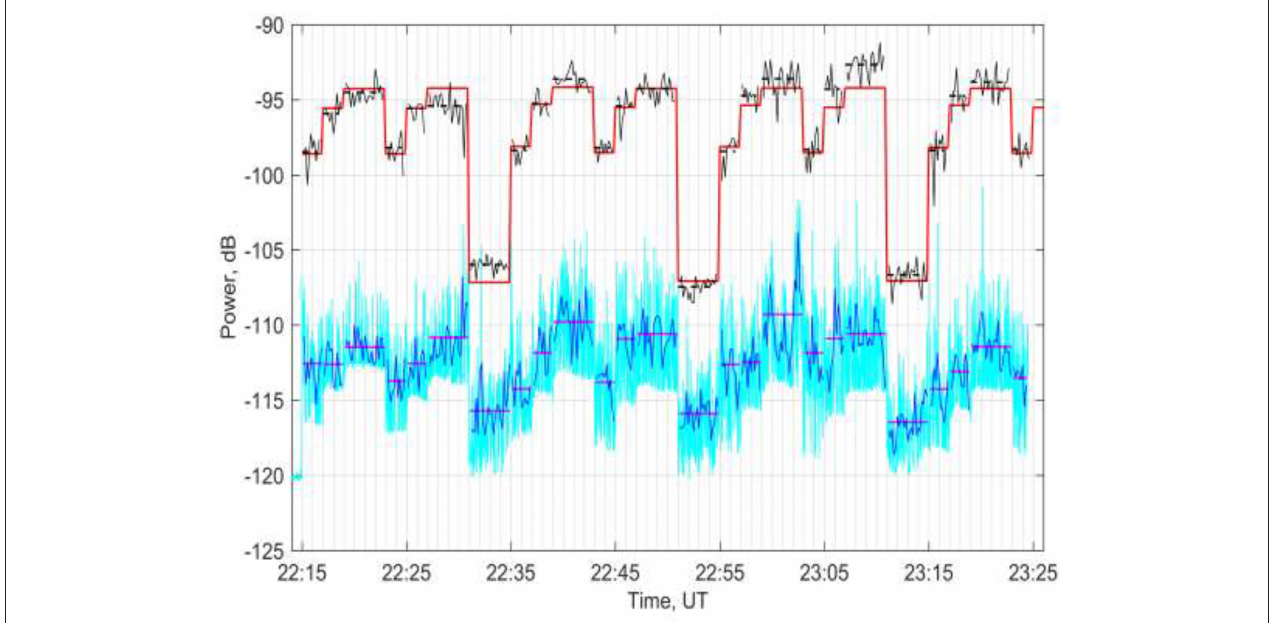
FIGURE 10 | Time series of the Arecibo heater signal received at UAS in the whole spectral band, and the peak intensity of the DM SEE signal received at Arecibo. Red histogram—log file of the heater, black curves—power of received signal at the UAS, black dashed lines an average level of signal power, turquoise curves—intensity of SEE. March 17, 2018.